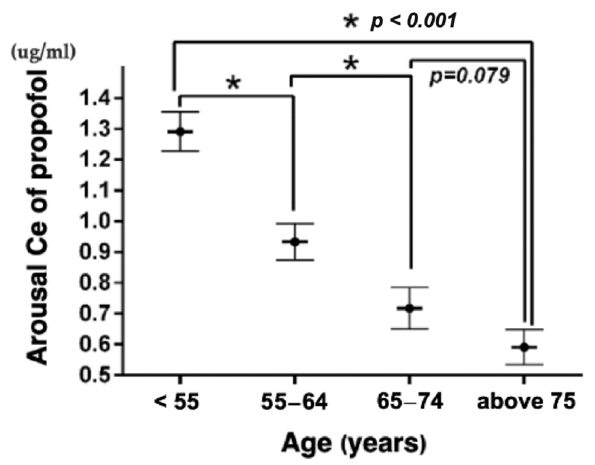
Figure 4. Comparison of the arousal effect-site concentration of propofol among different age groups using subgroup analysis. Ce, effect-site concentration.